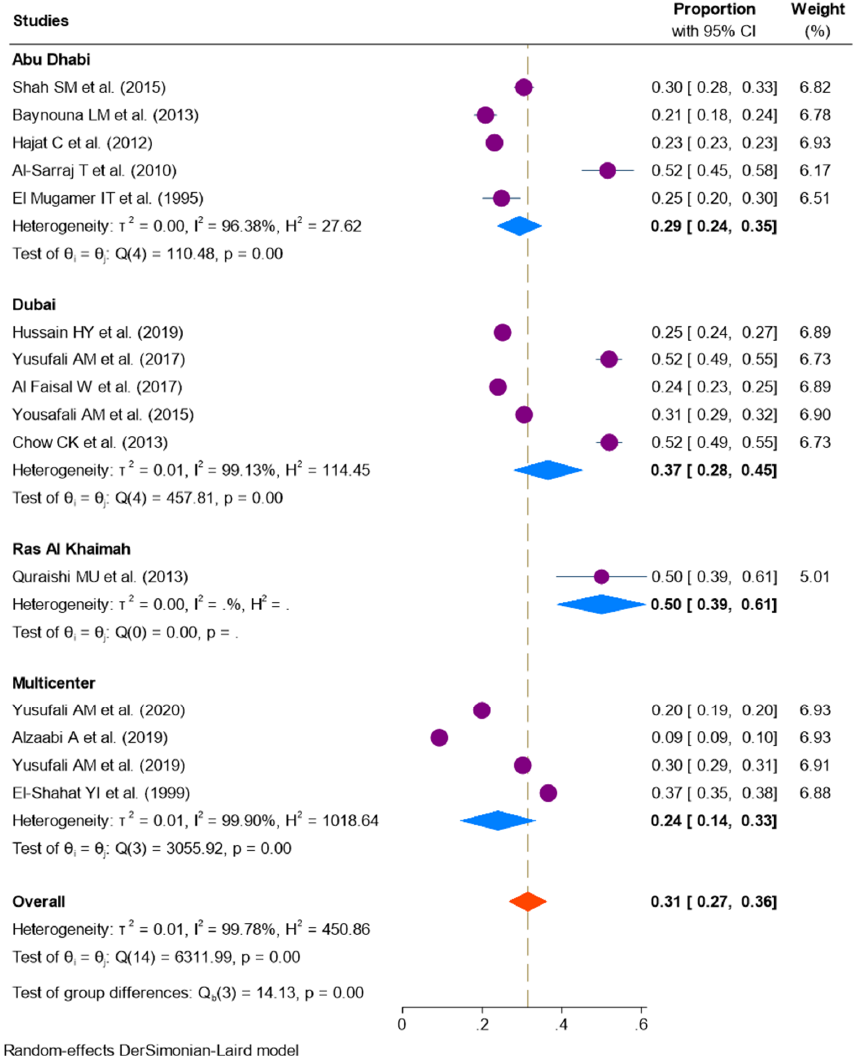
Figure 2. Prevalence of hypertension in the United Arab Emirates .